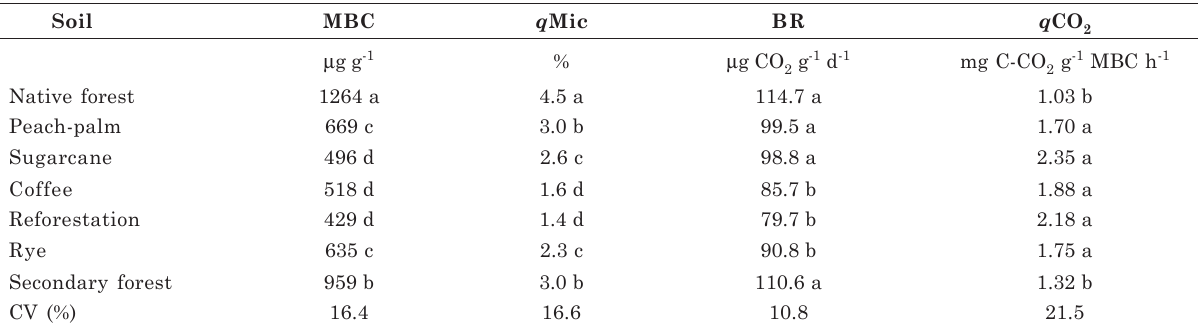
The same letters in the columns do not differ from each other by the Scott-Knott test at